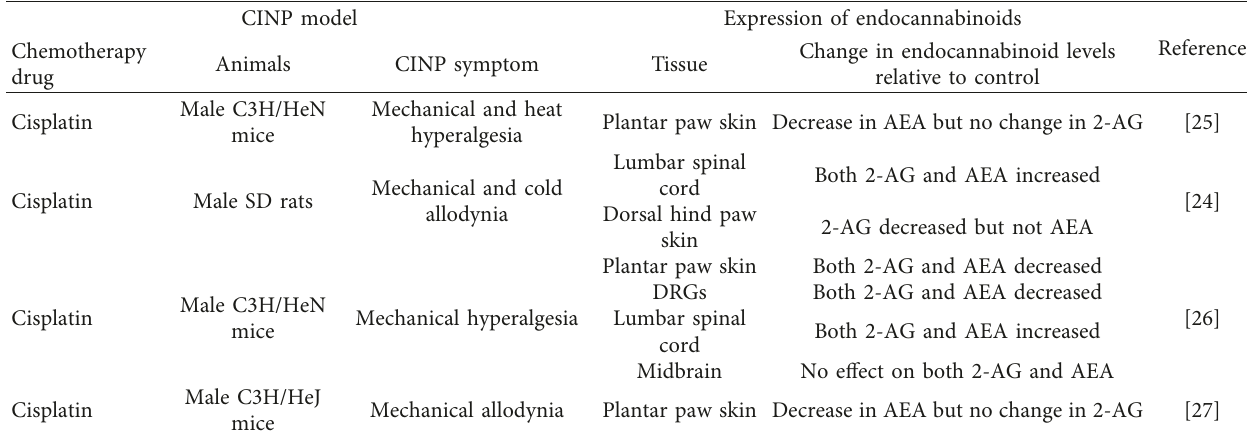
Table 1: Expression of endocannabinoids in animal models of CINP.